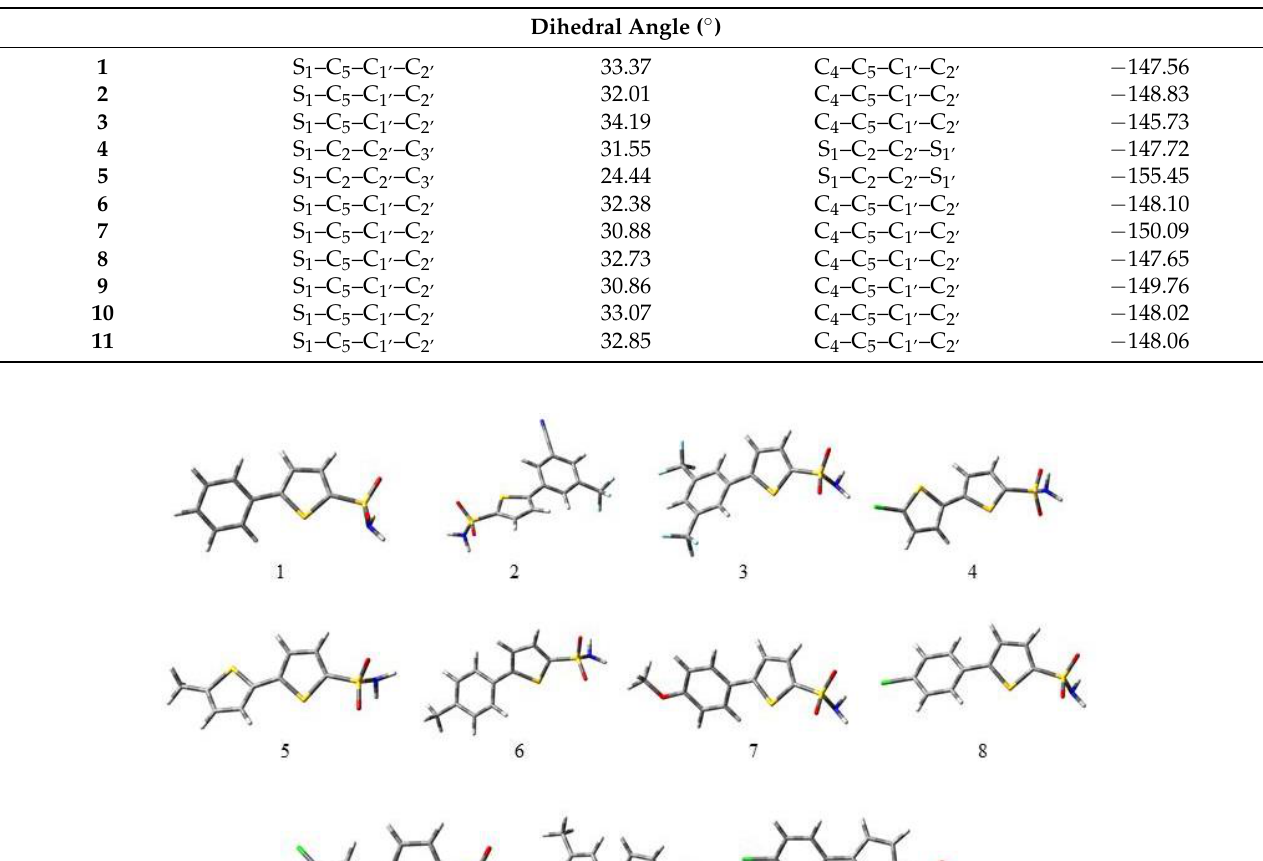
Table 3. Dihedral angles ( ◦ ) of selected dihedrals of 1 to 11 .